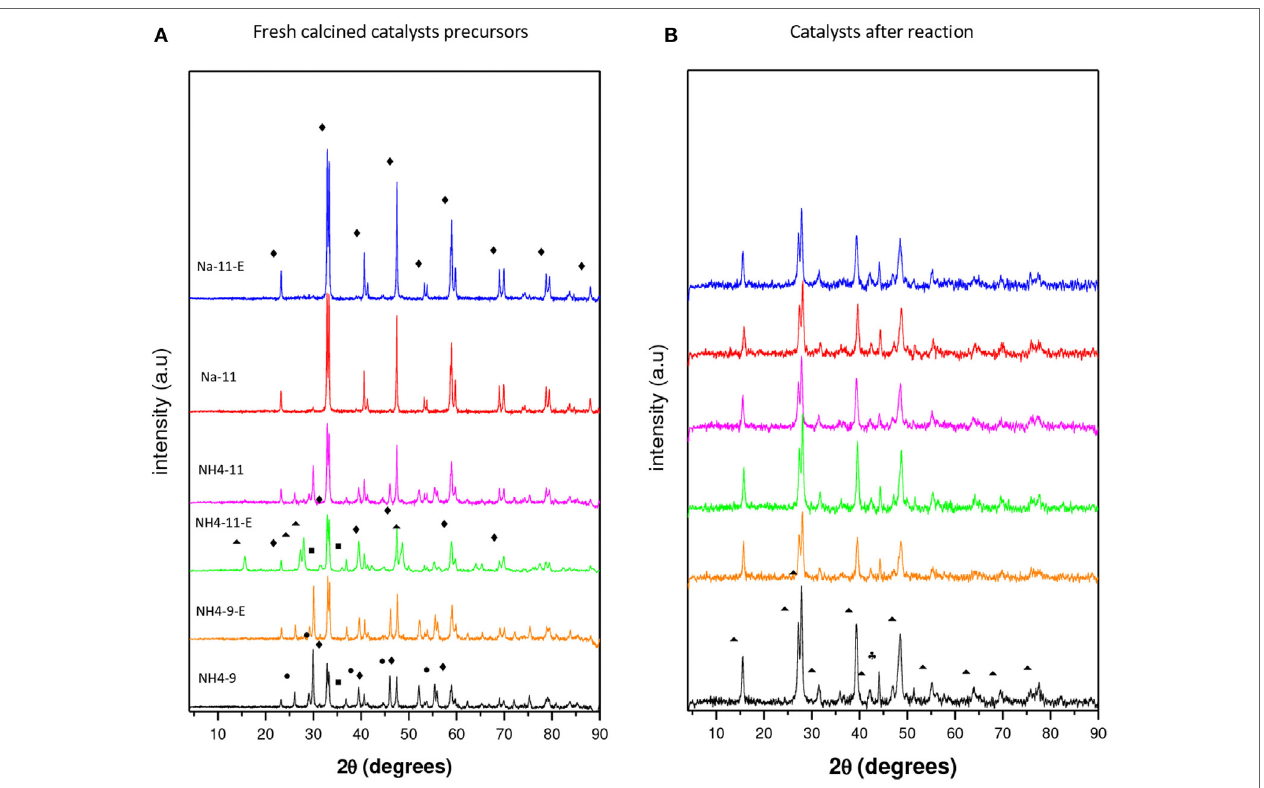
FigUre 3 | X-ray diffractograms of (a) fresh calcined samples and (b) catalysts after reaction ( ♦ : rhombohedral LaCoO 3 , ▪ : cubic Co 3 O 4 , •: hexagonal La 2 O 3 , 5: ▴ hexagonal La(OH) 3 , ♣ : Co 0